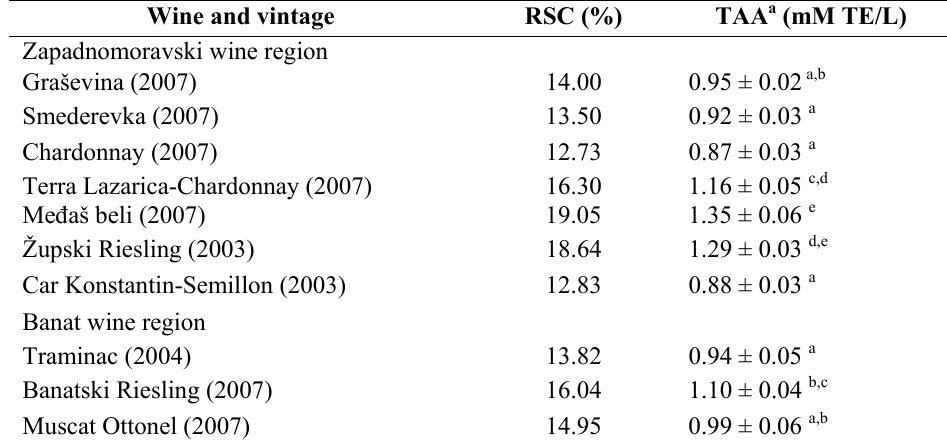
Table 3. Radical scavenging capacity (RSC) and total antioxidant activity (TAA) in different white wines.